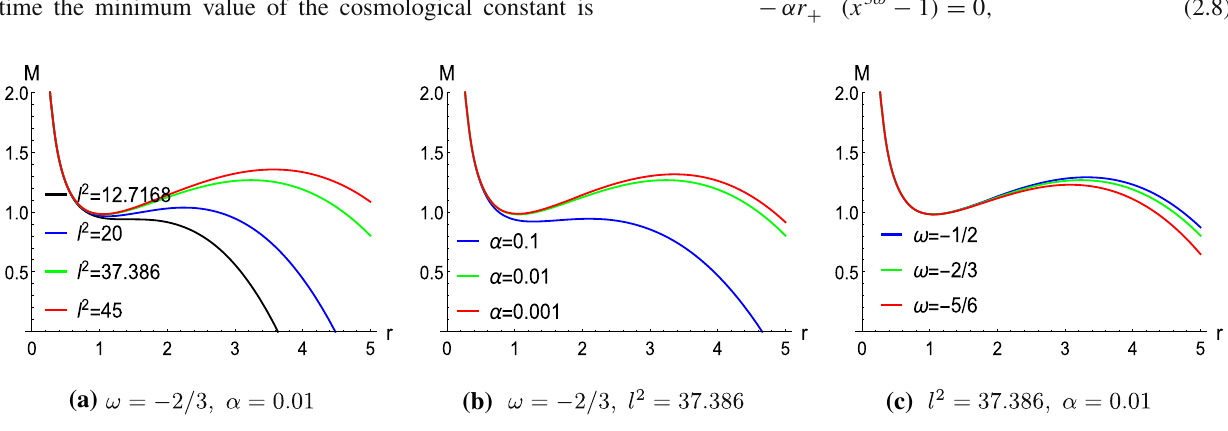
Fig. 2 M − r curves with different values of l 2 , α , and ω with Q =